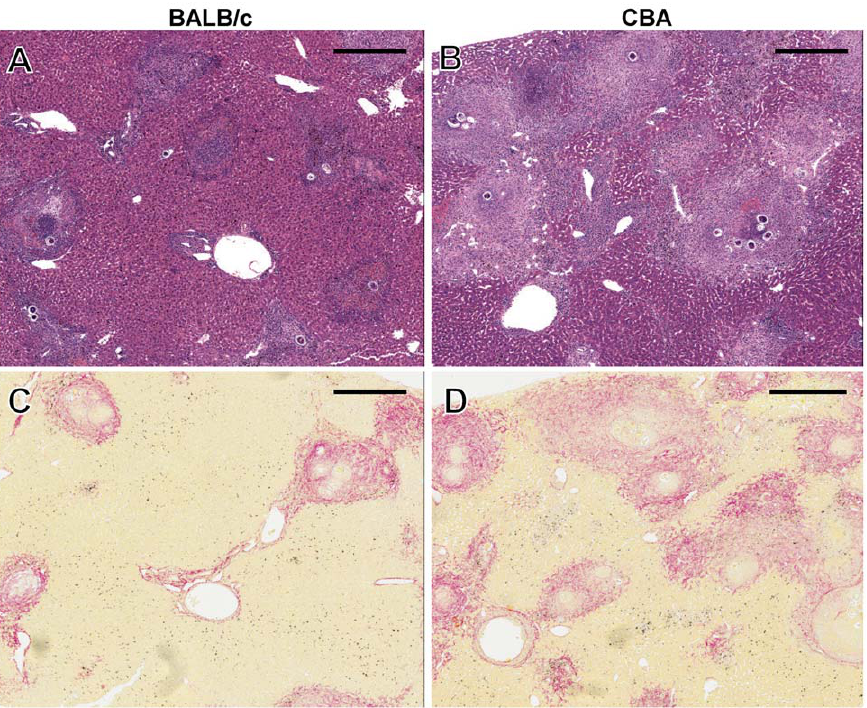
Figure 2. Histological staining highlights differences in tissue damage between BALB/c and CBA mice. Granulomatous pathology was more severe in CBA mice despite a similar egg burden ( A and B ; Haematoxylin and Eosin x40). Collagen deposition (red) was also greater in CBA mice ( C and D ; Sirius Red x40). All images were derived from mice at 7 weeks p.i. and were taken from murine livers with similar egg burdens. A and C ; B and D were taken from sections of the same mouse. Scale bar equals 400 m